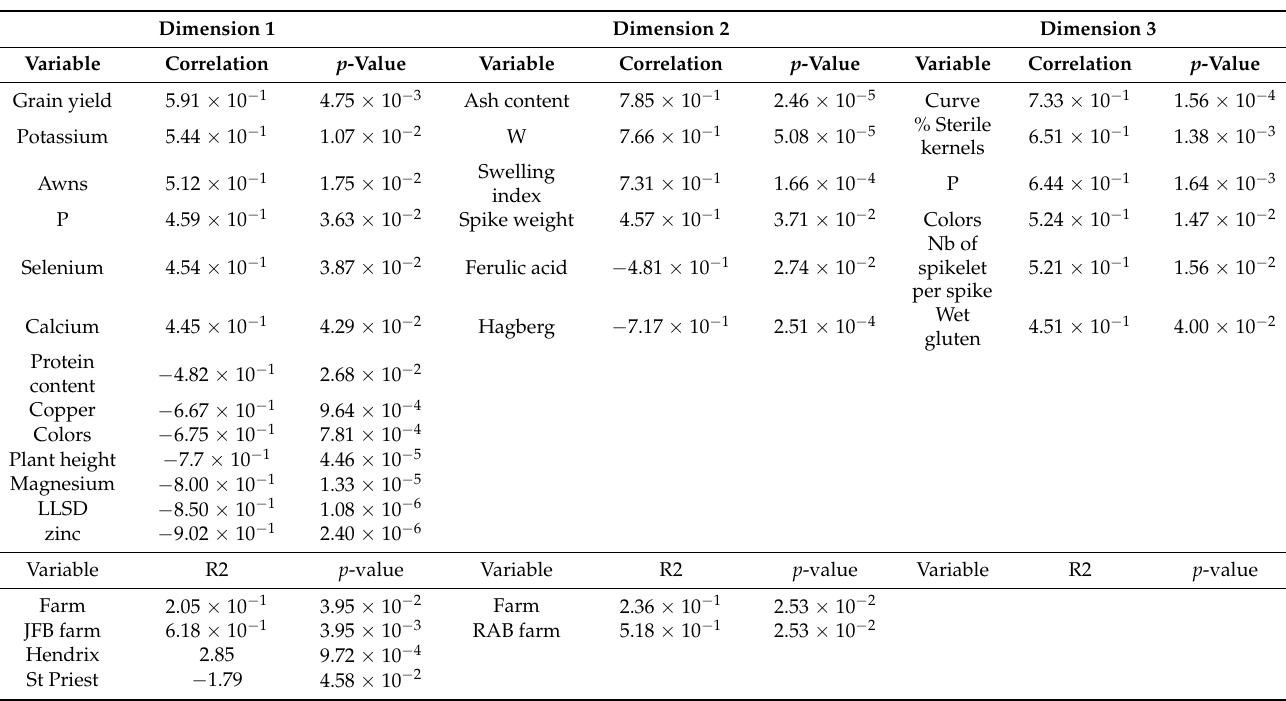
Table A2. Correlation and p -value for quantitative variables and Supplementary Group for the MFA in terms of agronomic, technologic, and nutrient content variables.